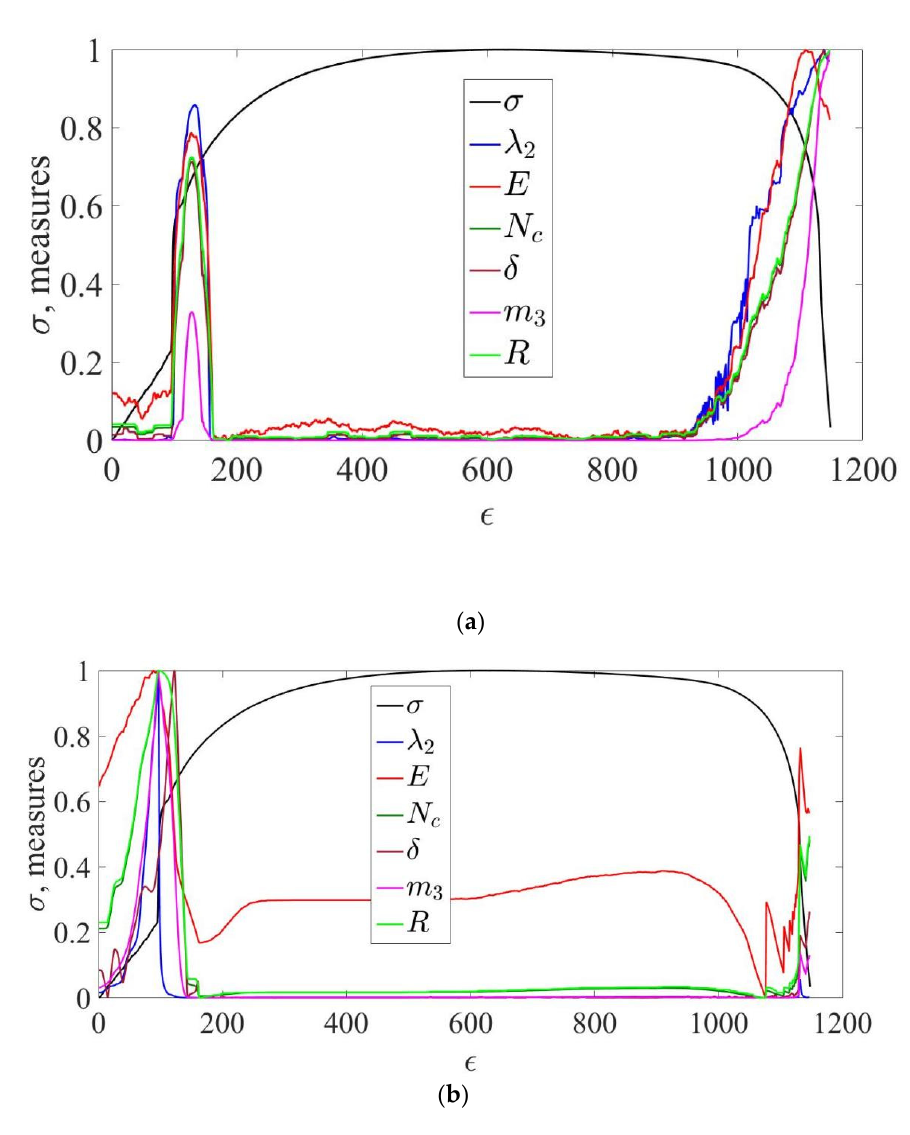
Figure 4. The spectral measures of complexity based on the VG (a) and the RP (b) approaches for the stress–strain time series.